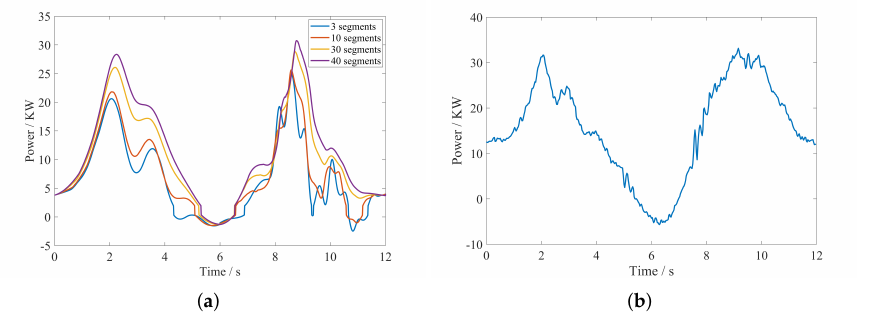
Figure 2. The comparison between the actual and generated MPCs with different segments of the rod. ( a ) Generated power curves. ( b ) Actual power